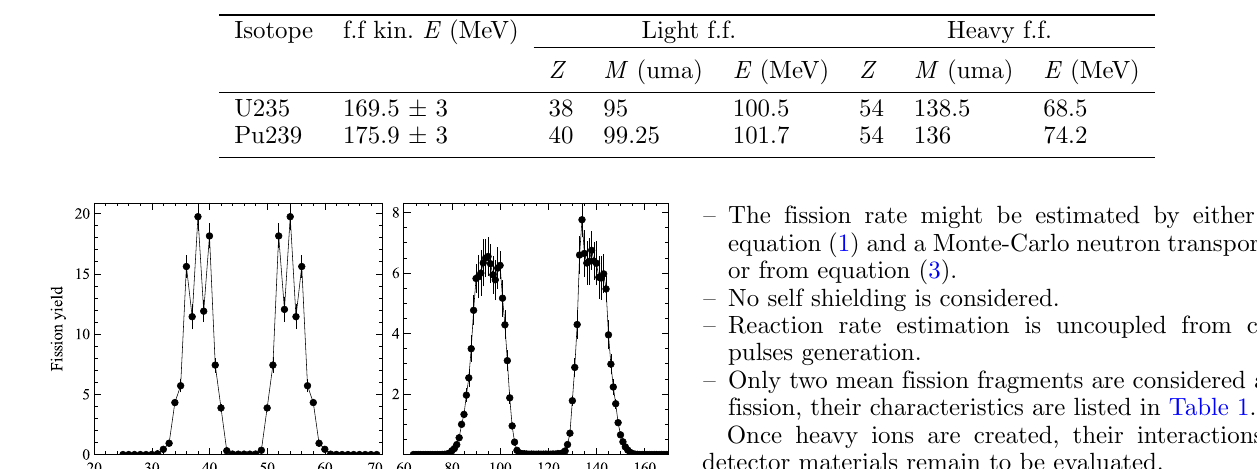
Table 1. Characteristics of the two mean fission fragments generated during the fission of uranium 235 and plutonium 239.